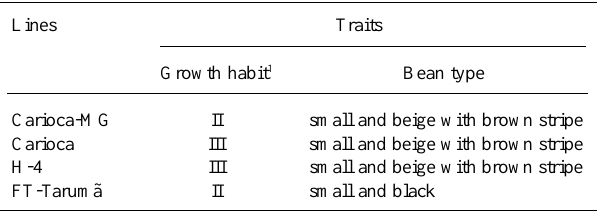
Table I - Bean lines used and their relevant traits. Lines Traits Growth habit 1 Bean type Carioca-MG